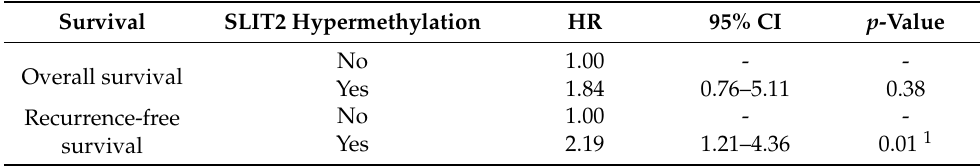
Table 1. Cox proportional hazards analysis of survival according to SLIT2